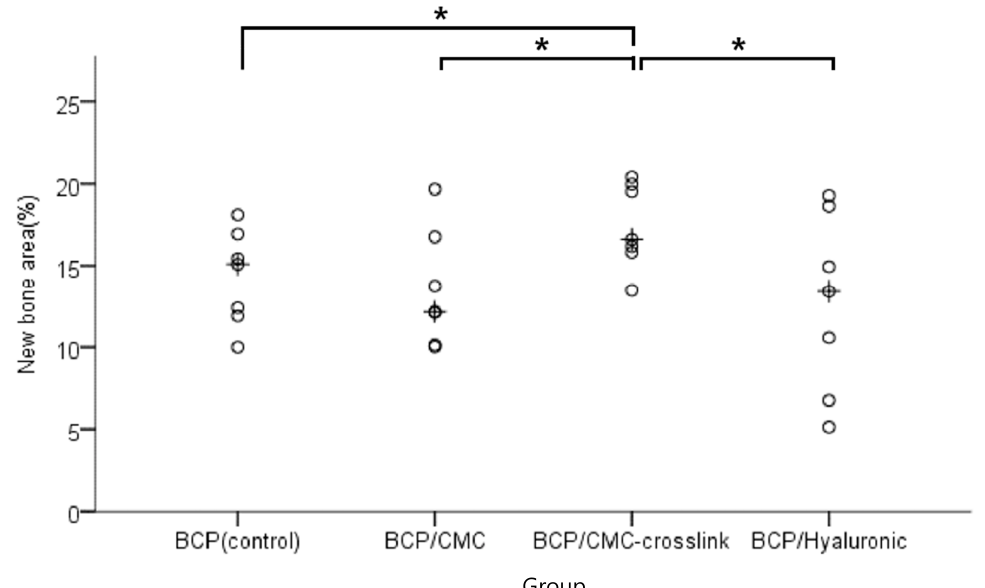
Figure 14. Scatter plot and median (indicated by the cross) of new bone areas (%). The BCP/c-CMC group exhibited more new bone area than the other three groups. The symbol “*” indicates statistical significance ( p < 0.05).